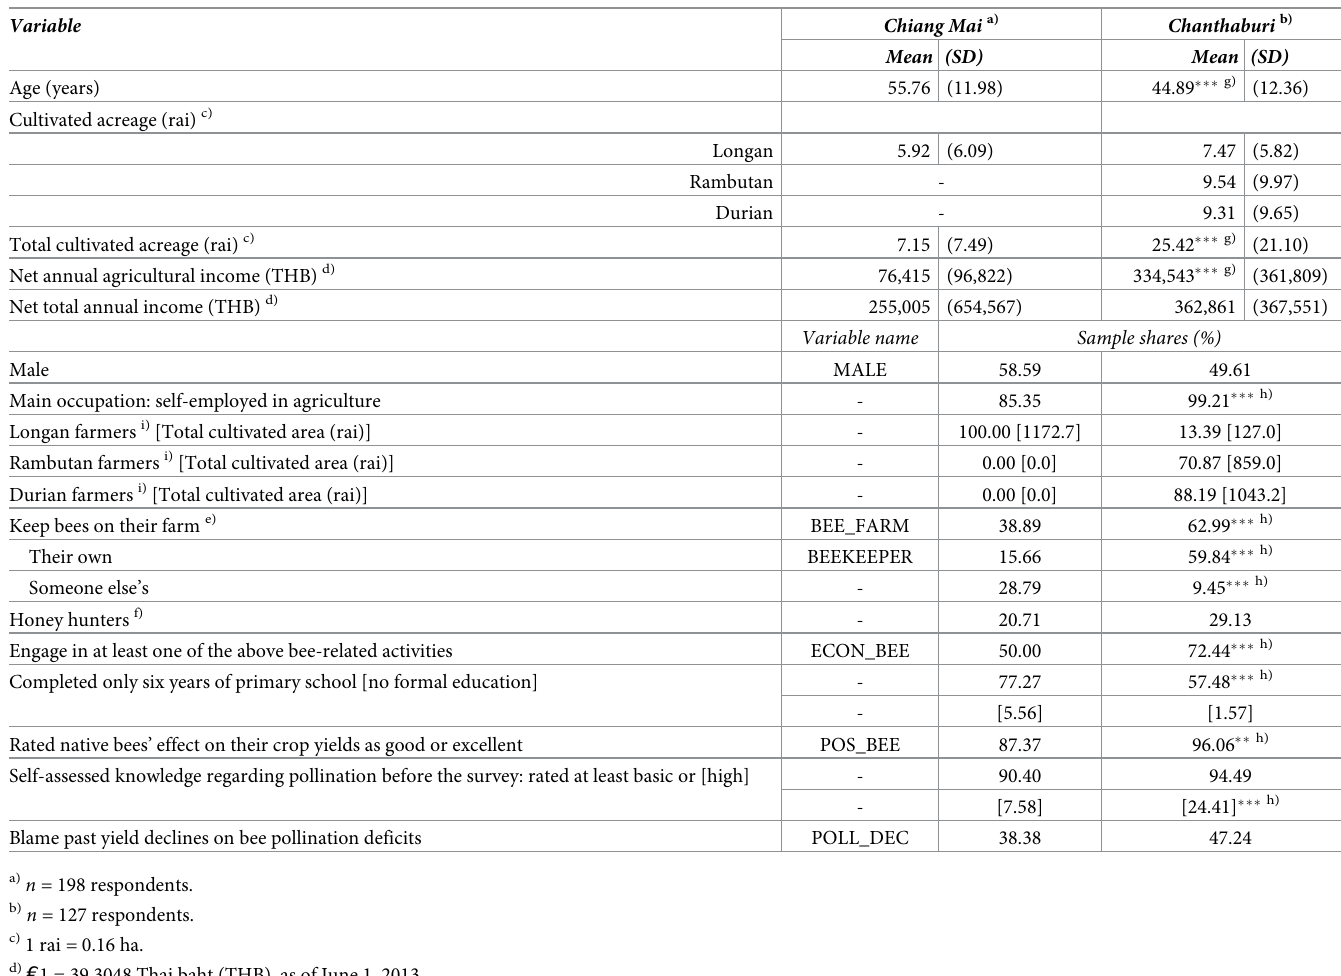
Table 2. Sample characteristics based on respondents’ per-household values,